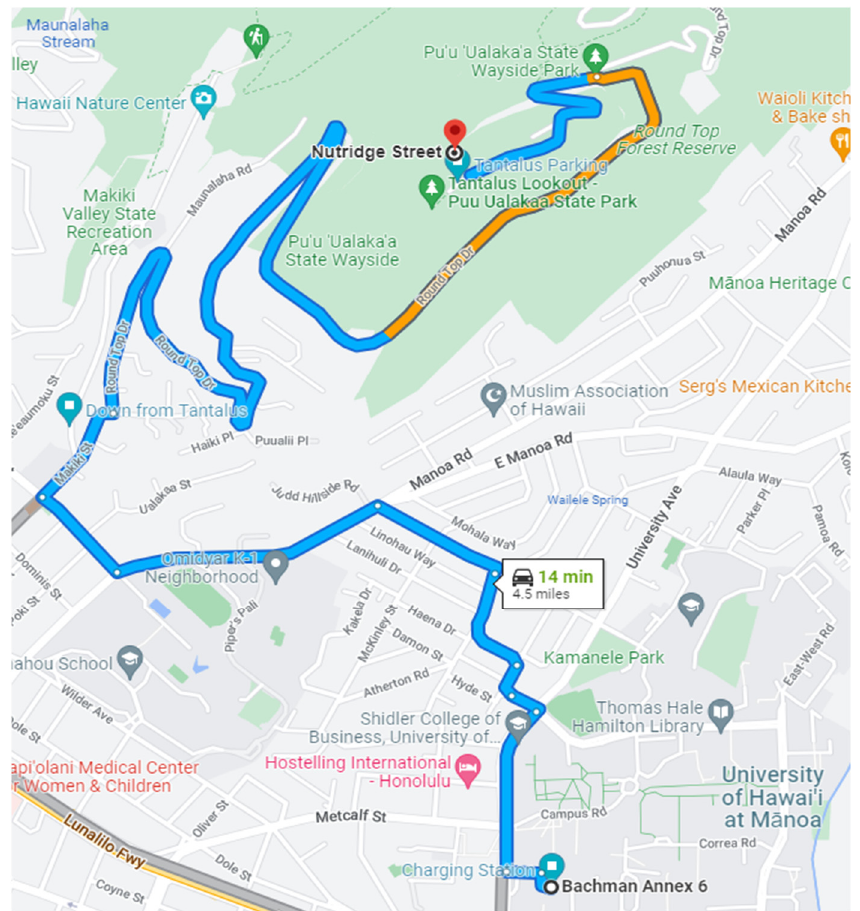
Figure 7. Route from University of Hawaii at Manoa to Tantalus Lookout on Google Map. Table 3. SOC estimation in each route’s